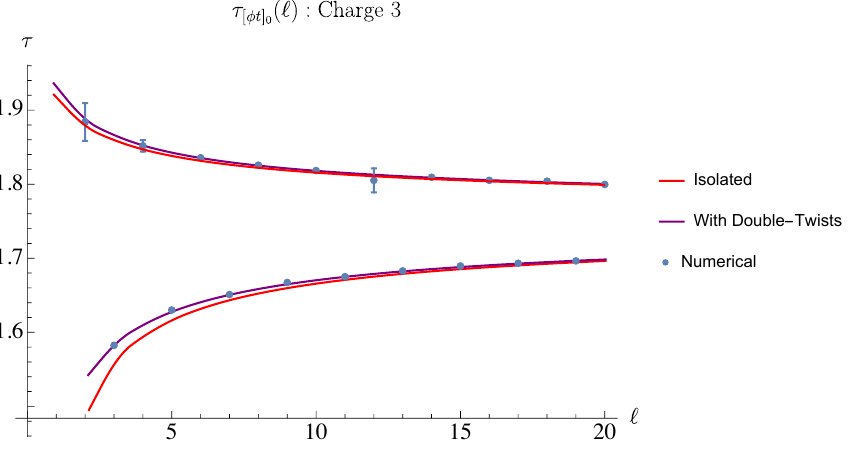
Figure 26 . The e(cid:11)ects of DTIs for leading double twists in the charge 3 [ (cid:30)t ] 3 curve corresponds to even spin and the lower curve corresponds to odd spin.